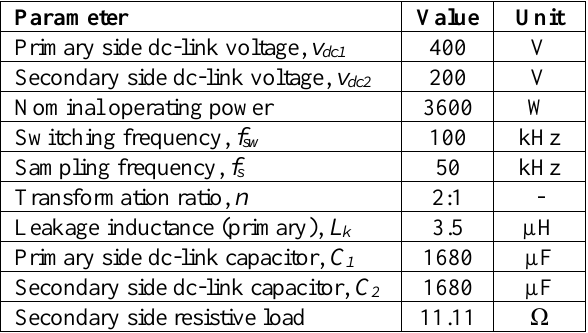
Table 1. DAB converter operating